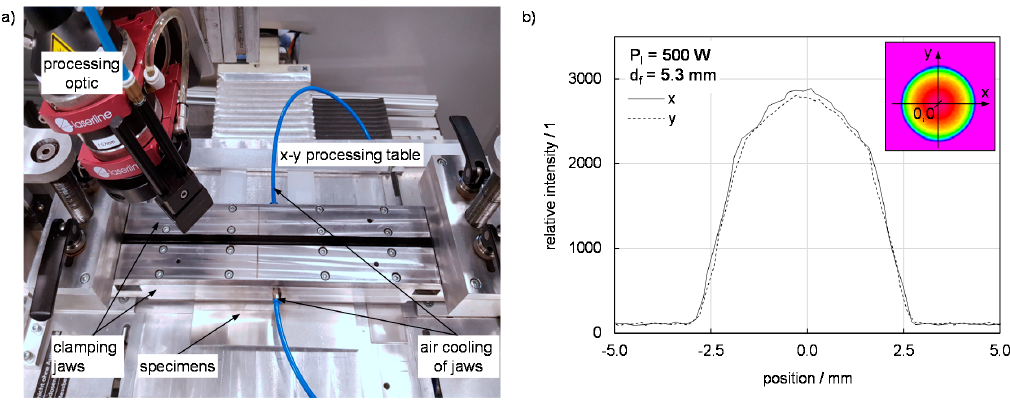
Figure 2. ( a ) Experimental setup and ( b ) schematic view of the joining zone with relevant parameters for thermal efficiency.